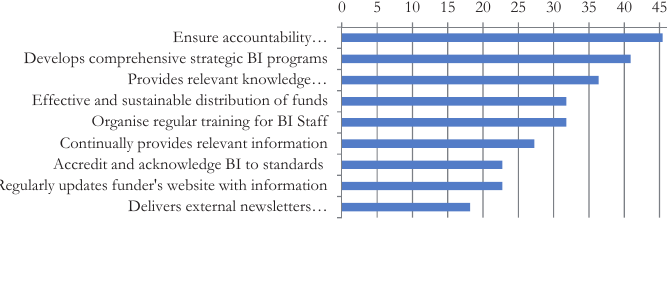
Fig. 5 – Important ratings of main sponsor. Source: